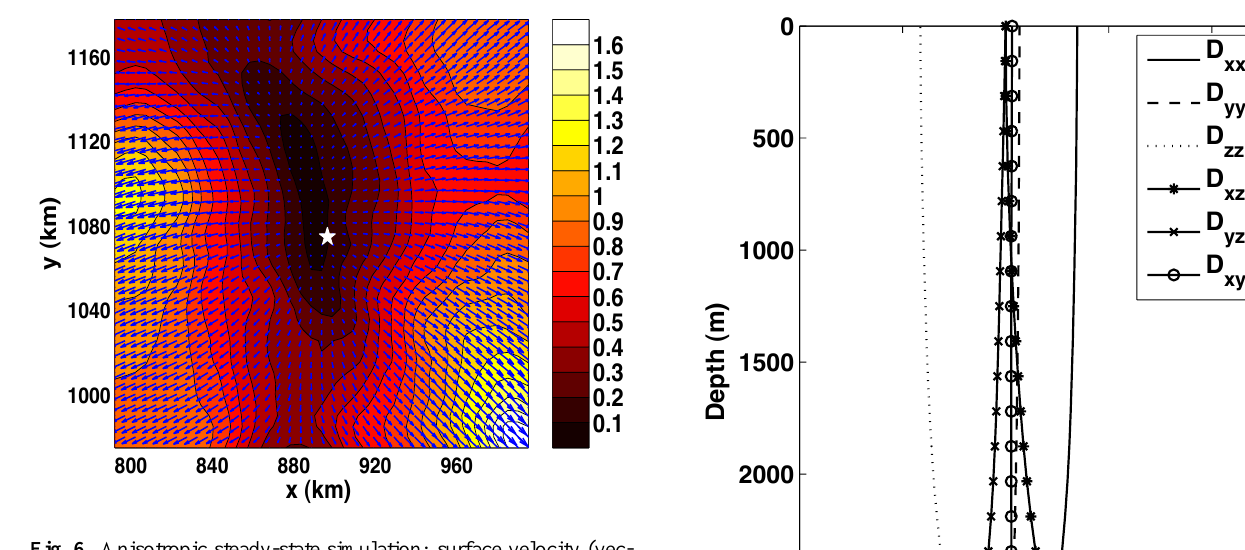
Fig. 6. Anisotropic steady-state simulation: surface velocity (vec- tors) and speed (colour map and contours, in ma − 1 , contour spac- ing 0 . 1 ma − 1 ). The white star indicates the location of the Dome Fuji drill site, north is towards the top right (see Fig. 1).